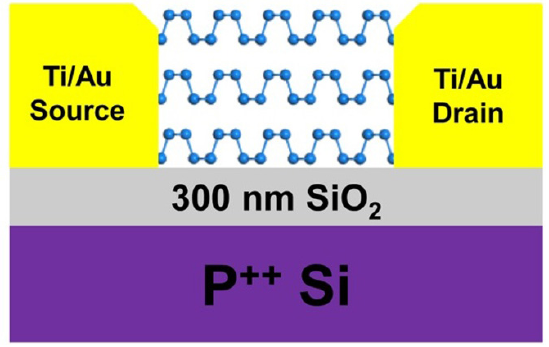
Figure 11. Scheme of a multilayer black phosphorus (BP) FET used for chemical sensing. Reprinted with permission from Ref. [93]. Copyright, 2015, American Chemical Society